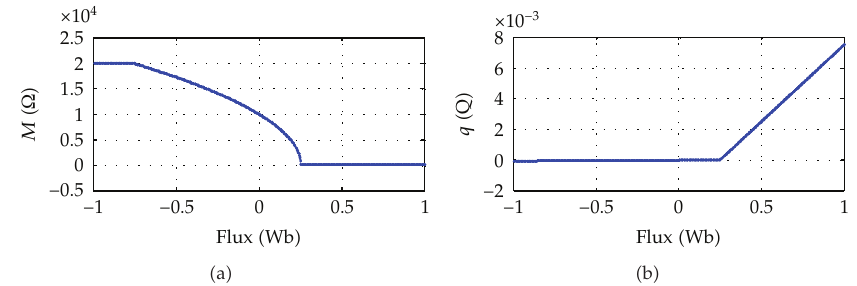
Figure 2: The M − ϕ and q − ϕ characteristics of